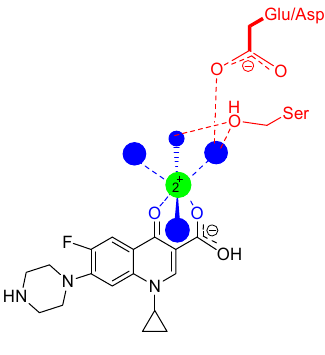
Figure 3. Quinolone-enzyme interaction [86].